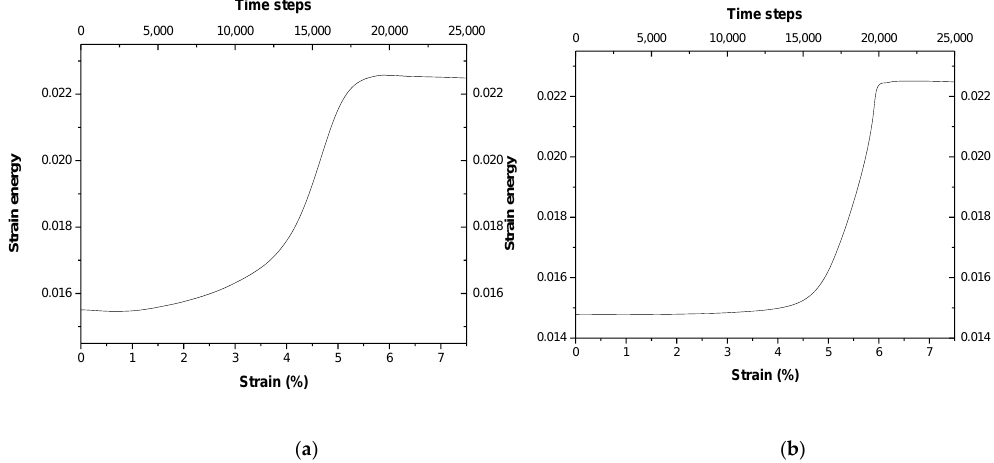
Figure 6. The localized strain energy change versus strain ( a ) in the zone of a rectangular region with red slash in Figure 4c; ( b ) in the zone of the original grain marked by grain 3 in Figure 4c. Figure 6a shows the localized strain energy change versus time and/or strain in a rectangular region with red slash in Figure 4c. It can be seen that the strain energy curve for the GB region